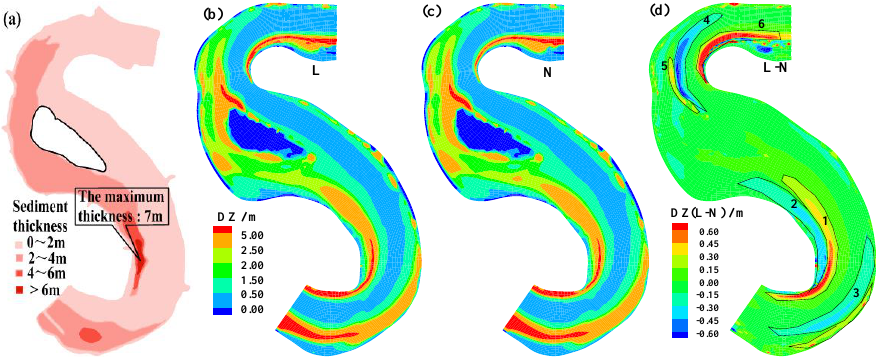
Figure 6. ( a ) Planar distribution of sediment thickness measured, the maximum is 7 m from March to August, 2012. ( b ) Sediment thickness simulated by the L model ( c ) and N model. ( d ) The difference between the L and N models.